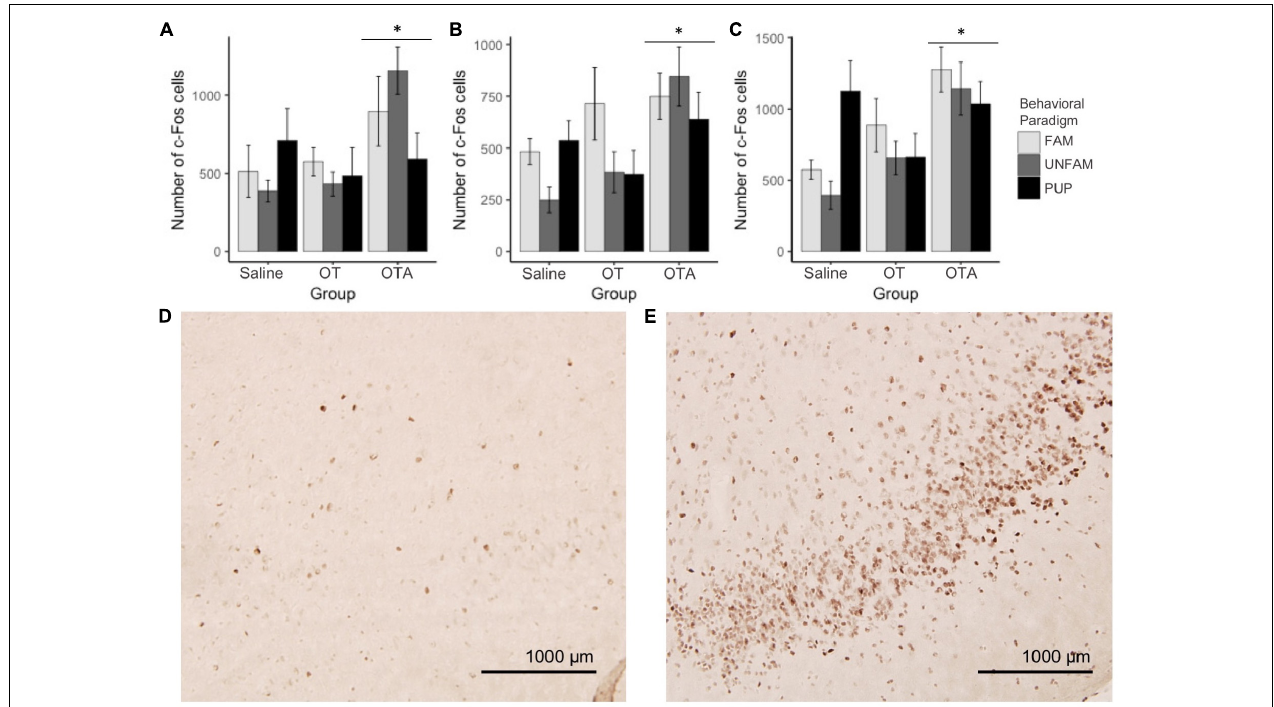
FIGURE 3 | Number of c-Fos cells ± SEM in brain regions where expression significantly varied by OT manipulation. OTA-treated animals had a significantly higher number of c-Fos cells in the (A) PIC ( p = 0.00167), (B) ACC ( p = 0.0014), and (C) PrL ( p = 0.000862). Photomicrographs showing the reduced c-Fos immunoreactivity in the PIC of a (D) saline-treated animal compared to the PIC of an (E) OTA-treated animal. PIC, piriform cortex; ACC, anterior cingulate cortex; PrL, pre-limbic